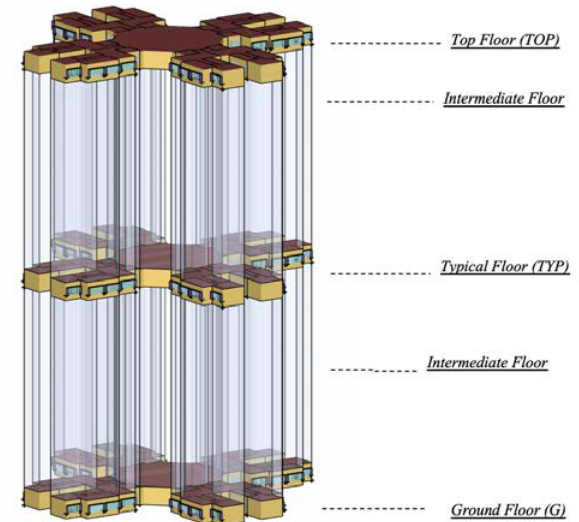
Figure 3. The sandwiched EnergyPlus Simulation Building Model. Note: top floor (TOP), ground floor (G) and typical floor (TYP). TOP—zone roofs and exterior walls exposed to outdoor condition; G—zone floors in contact with the earth, exterior walls to outdoor; TYP—zone exterior walls exposed to outdoor condition. Intermediate floors—the bu ff er zone between TOP and TYP as well as G and TYP to limit the heat flows and increase TYP floor